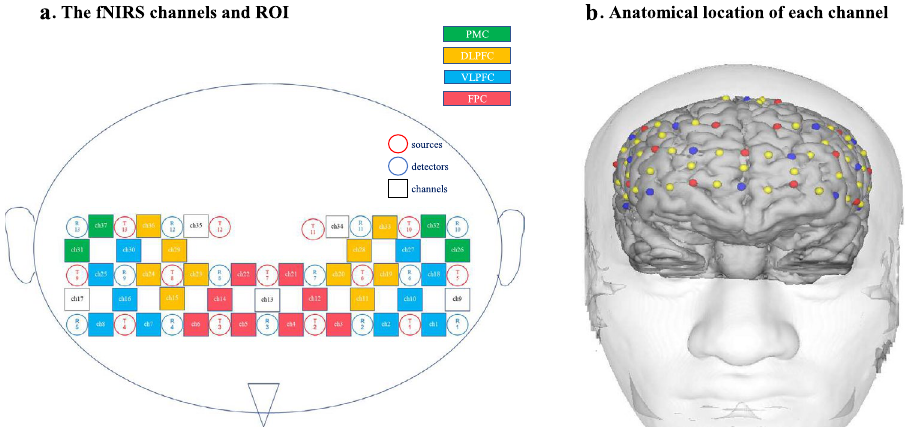
Figure 4. Schematics of the optode locations. ( a ) The functional near-infrared spectroscopy (fNIRS) channels and the regions of interest (ROIs). A total of 26 optodes, including 13 sources and 13 detectors, were arranged on the scalp to enable the measurement of 37 channels (Ch). The ROIs of the fNIRS Ch comprised areas of the ventrolateral prefrontal cortex (VLPFC; blue: Ch 7–8, 16, 25, and 30 in the right hemisphere; Ch 1–2, 10, 18, and 27 in the left hemisphere), dorsolateral prefrontal cortex (DLPFC; yellow: Ch 15, 23–24, 29, and 36 in the right hemisphere; Ch 11, 19–20, 28, and 33 in the left hemisphere), frontopolar cortex (FPC; pink: Ch 5–6, 14, and 22 in the right hemisphere; Ch 3–4, 12, and 21 in the left hemisphere), and the premotor cortex (PMC; green: Ch 31 and 37 in the right hemisphere; Ch 22 and 26 in the left hemisphere). The numbers (Ch 1–37) indicate the channels of the fNIRS probe. ( b ) Anatomical location of each channel. The anatomical locations of the optodes were digitized and superimposed onto three-dimensional surface-rendered magnetic resonance images of the